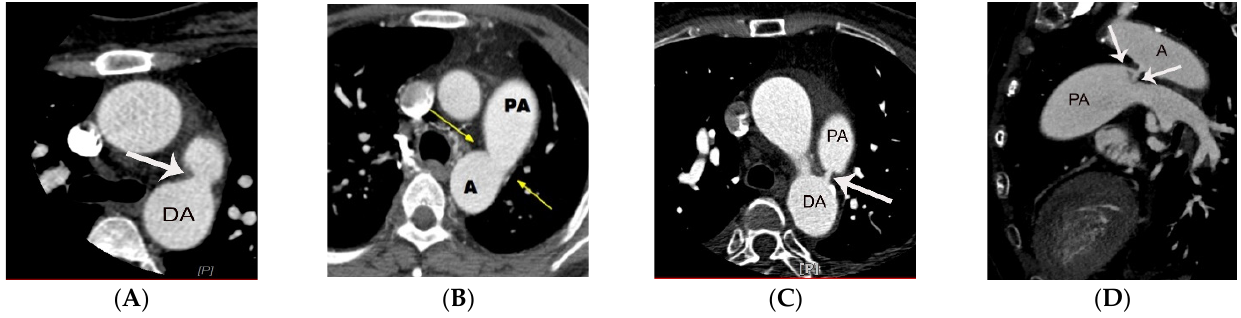
Figure 2. Representative cases of PDA subtypes (arrow on types A – D ). ECG-gated curved multi-planar CT image ( D ) shows a peculiar Y-shaped PDA that has two openings at the pulmonic end of PDA. The case may be categorized as a type D or an unclassified subtype of PDA. DA, A, and PA indicate descending aorta, aorta, and pulmonary artery, respectively.